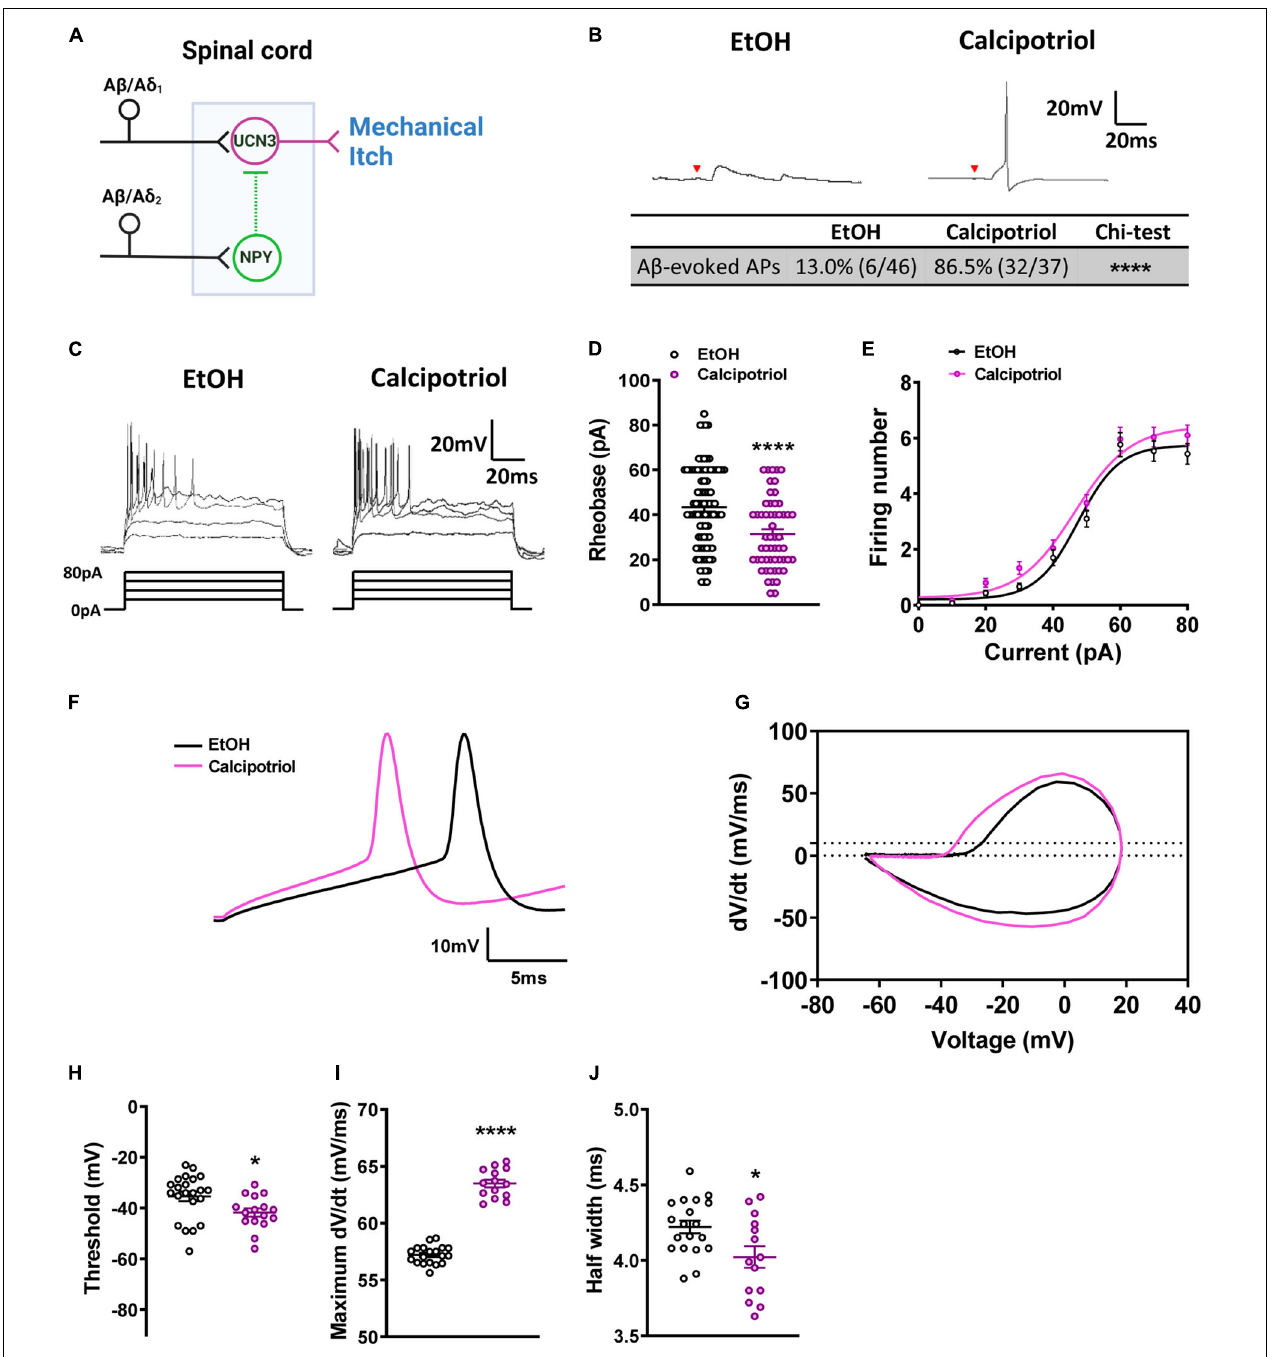
FIGURE 1 | Action potential properties in Ucn3 + neurons. (A) Schematic diagram of the mechanical itch circuit in the dorsal spinal cord. (B) A typical trace of A β -evoked action potentials (A β -eAPs) in the recorded Ucn3 + neurons. These data included recordings from 46 neurons of EtOH-treated mice and 37 neurons of calcipotriol-treated Ucn3 + mice. (C) Firing properties of Ucn3 + neurons in EtOH- and calcipotriol-treated Ucn3:Cre ; Ai14 mice. The majority of Ucn3 + neurons display an initial bursting firing pattern upon current injection. (D) Average AP rheobase in control and chronic itch mice. Control, n = 88; chronic itch, n = 55. **** p < 0.0001. Student’s unpaired t -test. (E) Average AP firing numbers responding to depolarizing currents in control and chronic itch mice. Control, n = 30; chronic itch, n = 30, no significant difference. ANOVA test. (F) Single AP induction upon current injection of Ucn3 + neurons in control and calcipotriol-treated chronic itch mice. (G) Phase plot (dV/dt vs. V) of the APs from (F) . (H) Average AP threshold in control and chronic itch mice. Control, n = 22; chronic itch, n = 14. * p < 0.05. Student’s unpaired t -test. (I) dV/dt during the transition from the resting membrane potential to the AP peak in control and chronic itch mice. Control, n = 19; chronic itch, n = 14. **** p < 0.0001. Student’s unpaired t -test. (J) Average AP half width in control and chronic itch mice. Control, n = 19; chronic itch, n = 14. * p < 0.05. Student’s unpaired t -test.